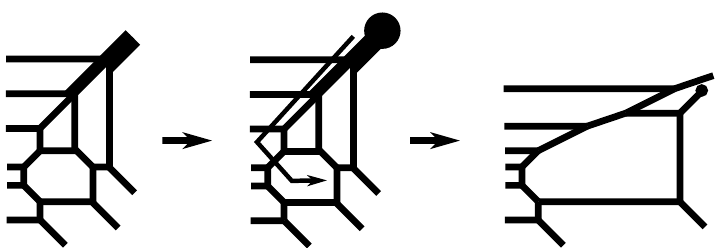
Figure 16. A deformation of the diagram after the Higgsings which breaks SU(3) to a diagram of the SU(6) 1 − SU(2) 0